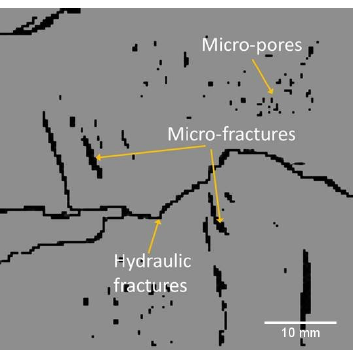
Figure 1. Sketch of the fractures and micropores within fractured reservoir rocks.